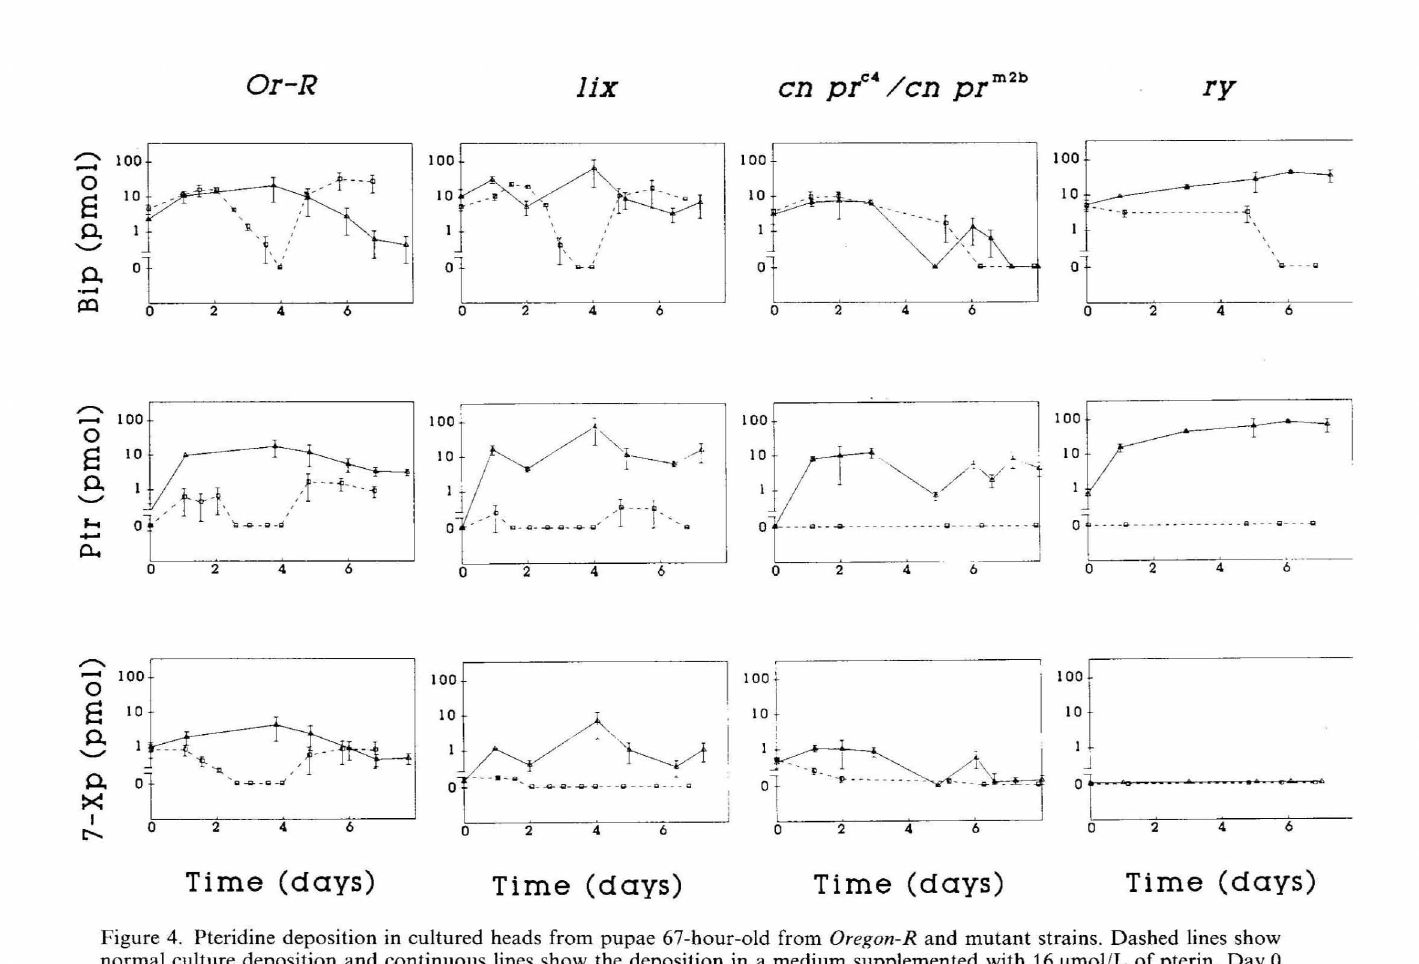
Figure 4, Pteridine deposition in cultured heads from pupae 67-hour-old from Oregon-R and mutant strains, Dashed lines show normal culture deposition and continuous lines show the deposition in a medium supplemented with 16 Ilmol(L of pterin. Day 0 refers to the moment when culture was started. Each point represents the mean of two to three determinations and bars are standard errors of means.